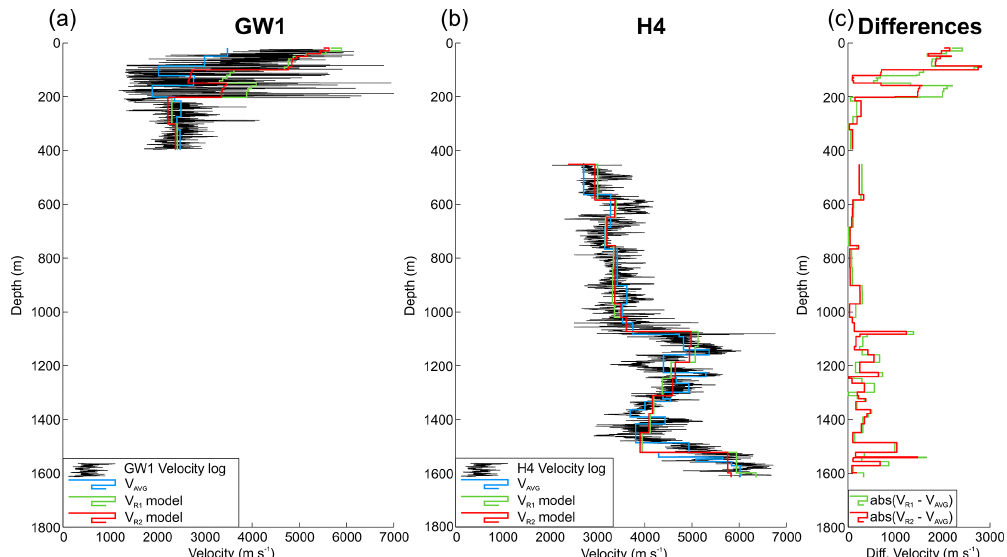
Figure 7. Velocity log data (in black), 1-D velocity models provided by V R1 (in green), V R2 (in red), and V AVG (in blue) for the GW1 (a) and the H4 (b) wells and differences between the V R models and V AVG (c) .